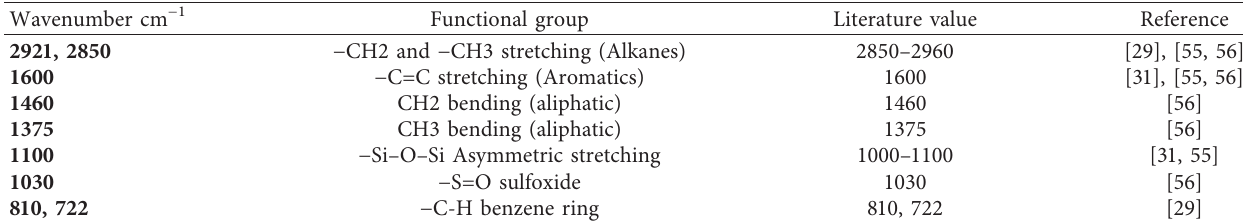
Figure 11: Infrared spectrum. (a) Tego XP additive. (b) Addibit additive. (c) CRM +0.6% Tego XP. (d) CRM+2% Addibit. (e) CRM control binders. Table 6: FT-IR spectral data of CRM binders with and without WMA